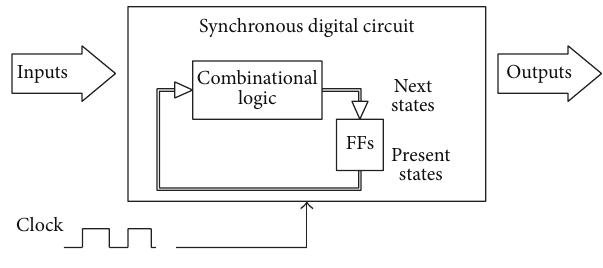
Figure 1: Synchronous digital circuits